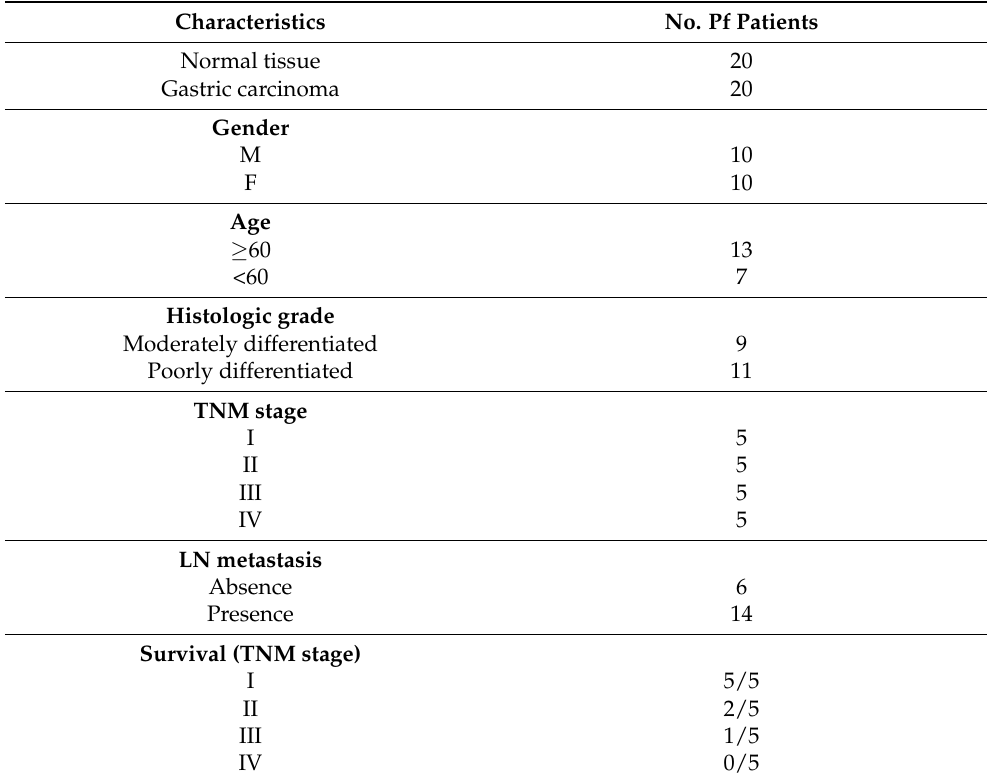
Table 1. Clinicopathological characteristics of GC